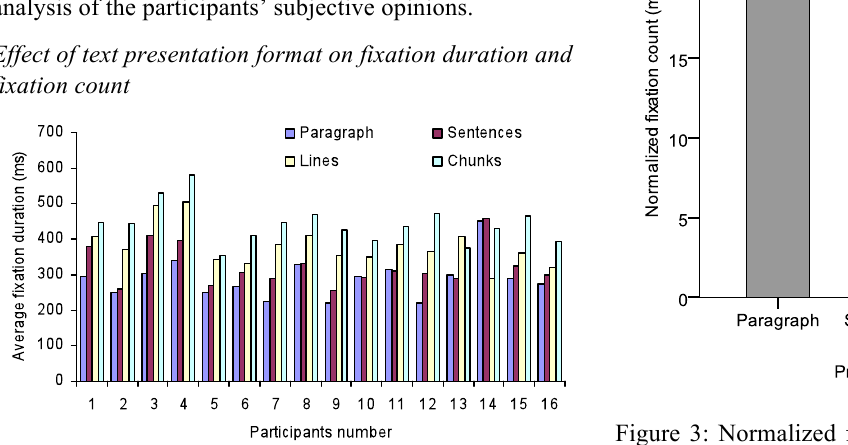
Figure 3: Normalized fixation count with different pres- entation formats (automatic pacing). The error bars repre- sent the standard error of the